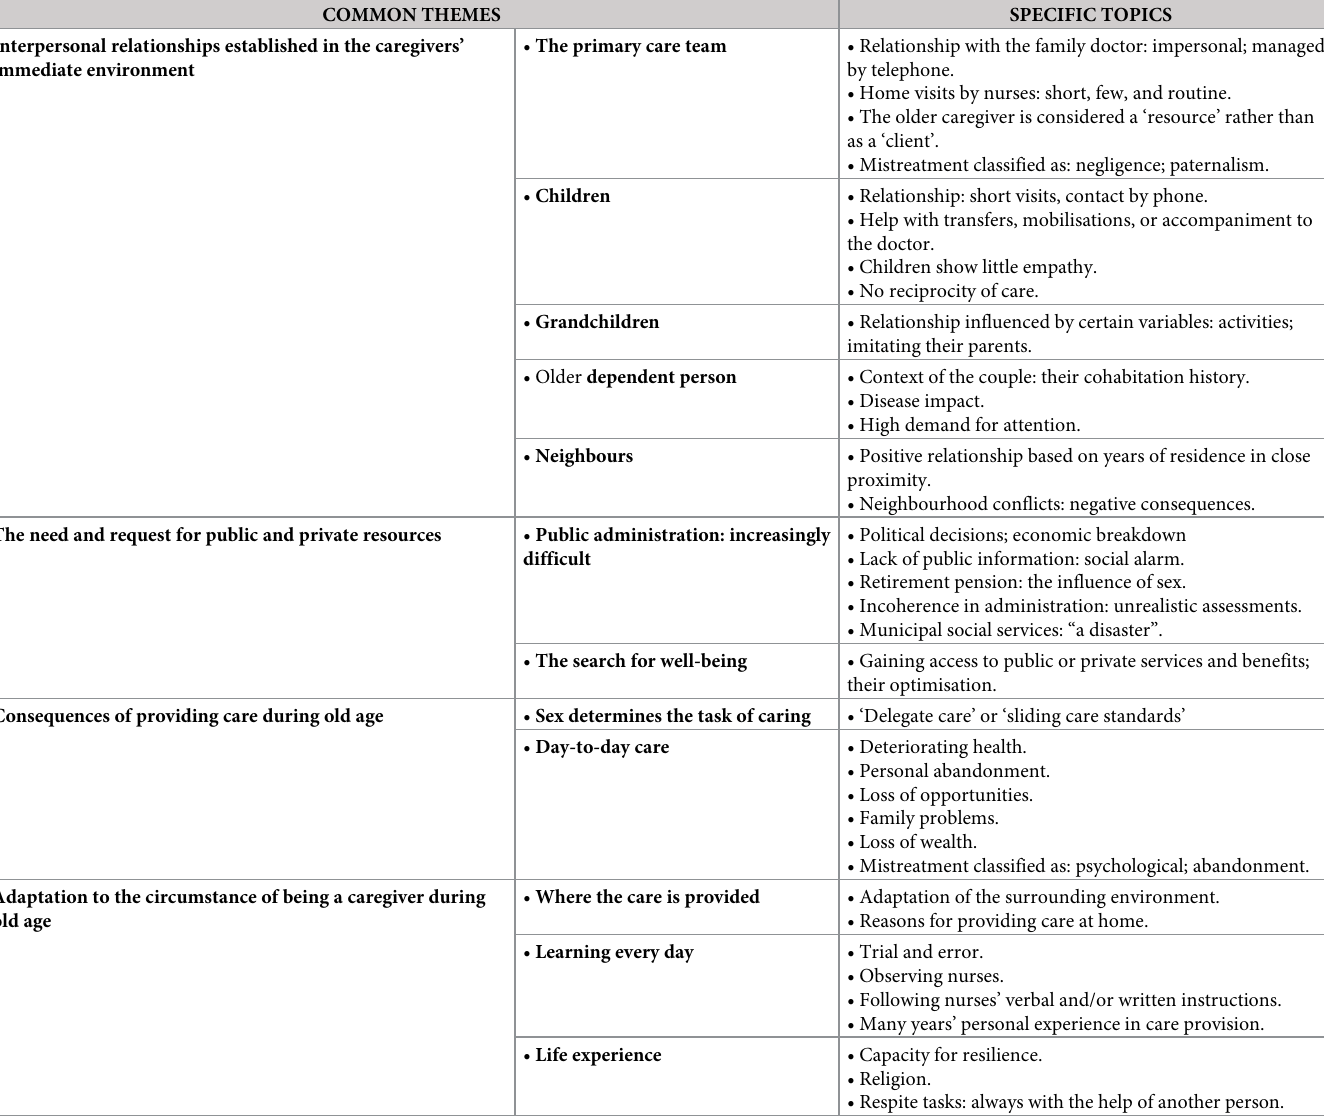
Table 2. Summary: Analysis of the experience of providing care to older dependents at home during old